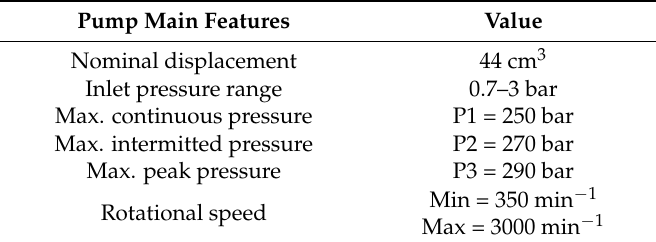
Figure 1. ( a ) Casappa KP30, ( b ) exploded vision of the pump drawing. Table 1. Pump main features—Casappa KP30.